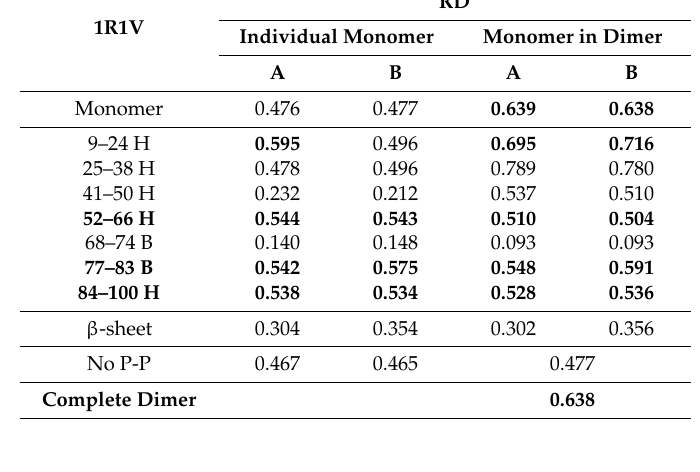
Table 4. RD coefficients describing the status of the hydrophobic core in the dimer and in each monomer of 1R1V. Values given in bold are fragments of status expressed by RD > 0.5. H and B denote the secondary form of the particular fragment, helical and β -structural respectively. Position “No P-P” expresses the status of dimer with residues in interface eliminated form calculation.